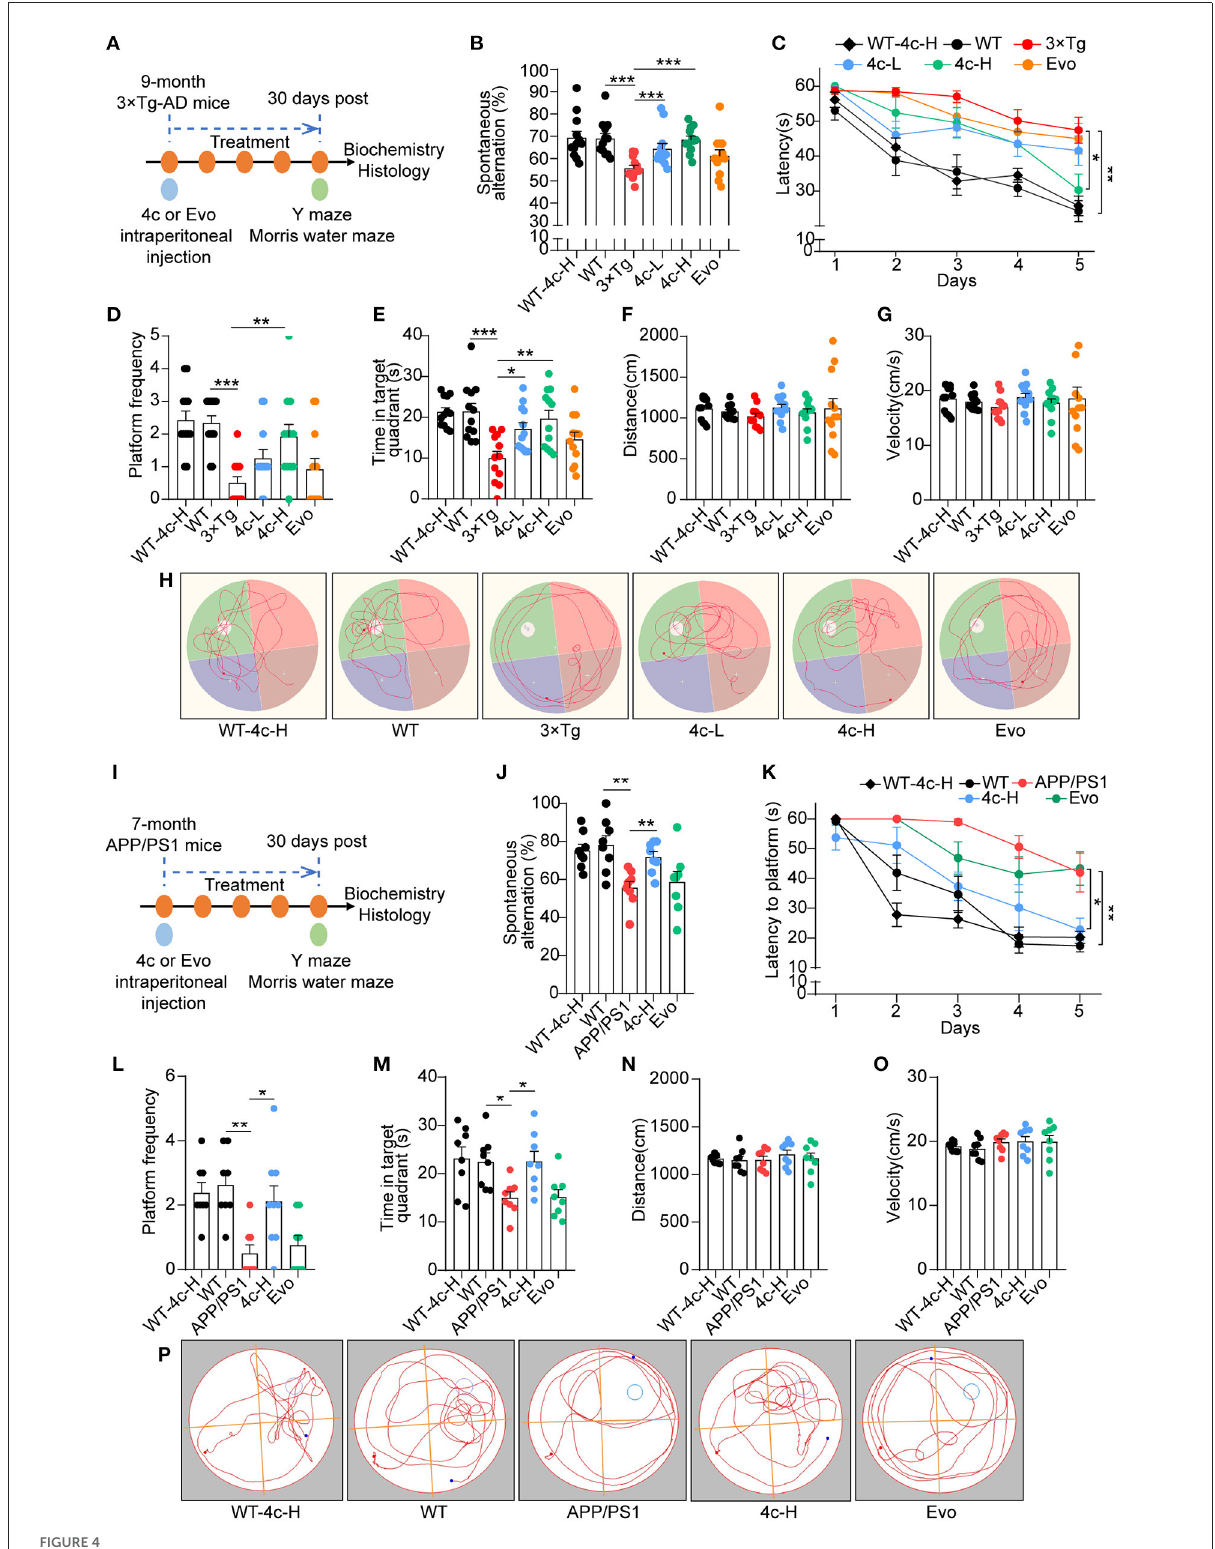
FIGURE4 Analysis of the cognitive behavior of 3 x Tg and APP/PS1 AD mice treated with 4c . (A) Schematic diagram of the experimental design for treating 3 x Tg-AD mice with 4c . Six groups of mice were treated every 2 days for 4 weeks: WT with 200 µ g/kg 4c (WT-4c-H), WT with vehicle (WT), 3 x Tg with vehicle (3 x Tg), 3 x Tg with 20 µ g/kg 4c (4c-L), 3 x Tg with 200 µ g/kg 4c (4c-H), and 3 x Tg with 200 µ g/kg Evo (Evo). (B) After